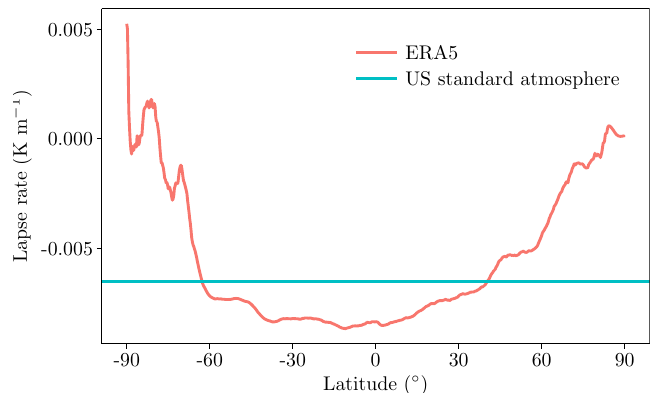
Figure 3. Zonal mean lapse rate from the ERA5 analysis and from the US standard